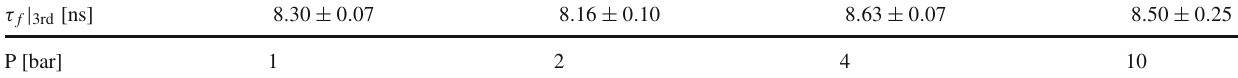
tered PM in high pressure conditions (to minimize contamination from 3rd continuum emission) was τ f | 2nd = 5 . 2 ± 1 . 0 ns while the highest value achieved for the slow (triplet) component (at E > 50 V/cm/bar)